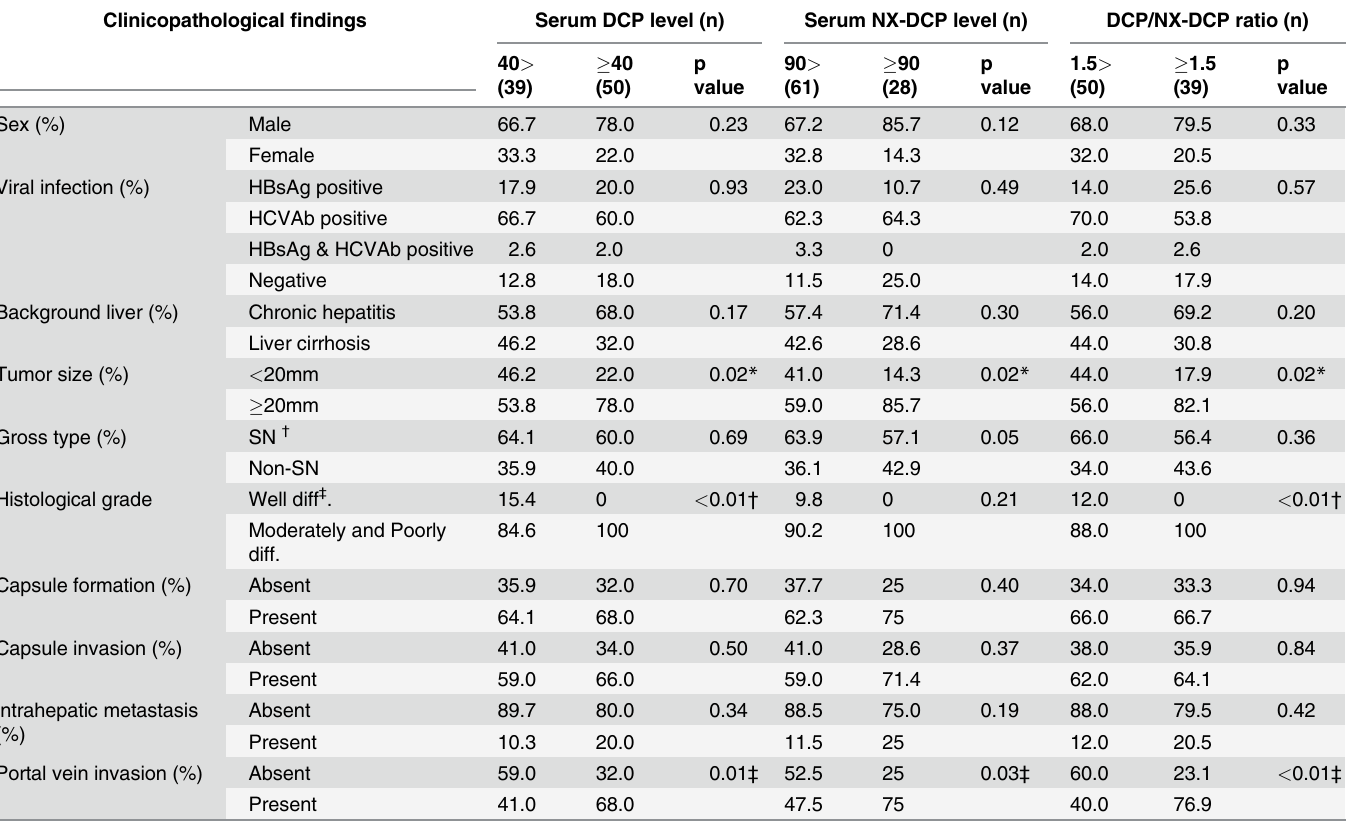
Table 2. Relationship between clinicopathological features and serum DCP level, serum NX-DCP level or DCP/NX-DCP ratio in HCC. Clinicopathological fi ndings